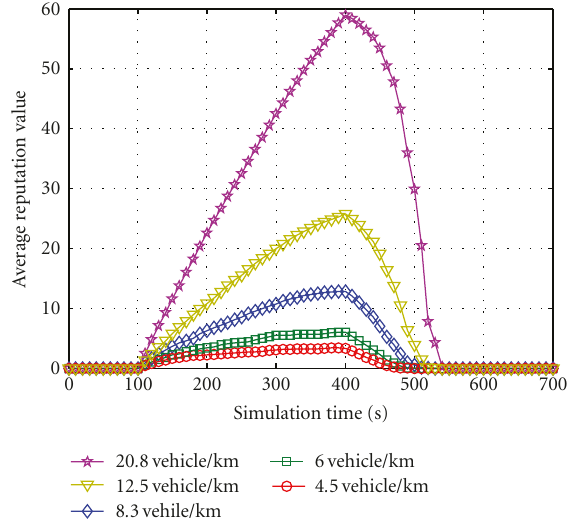
Figure 9: 2-based exponent function is adopted as the degradation function, D ( N te ) = 2 N te .